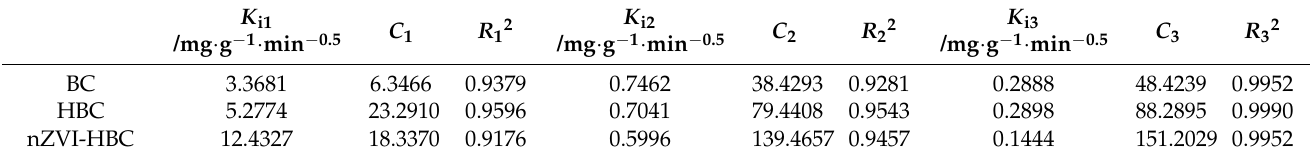
Table 4. Intra-particle diffusion model fitting parameters of OTC adsorption of BC, HBC, and nZVI-HBC.